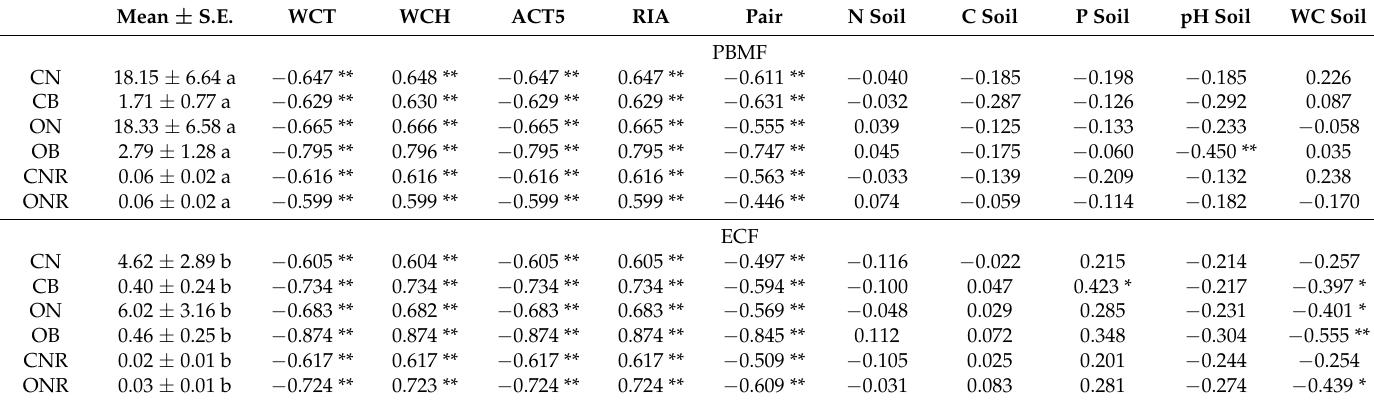
Table 6. Growth properties of each forest type and their correlation coefficients with environment